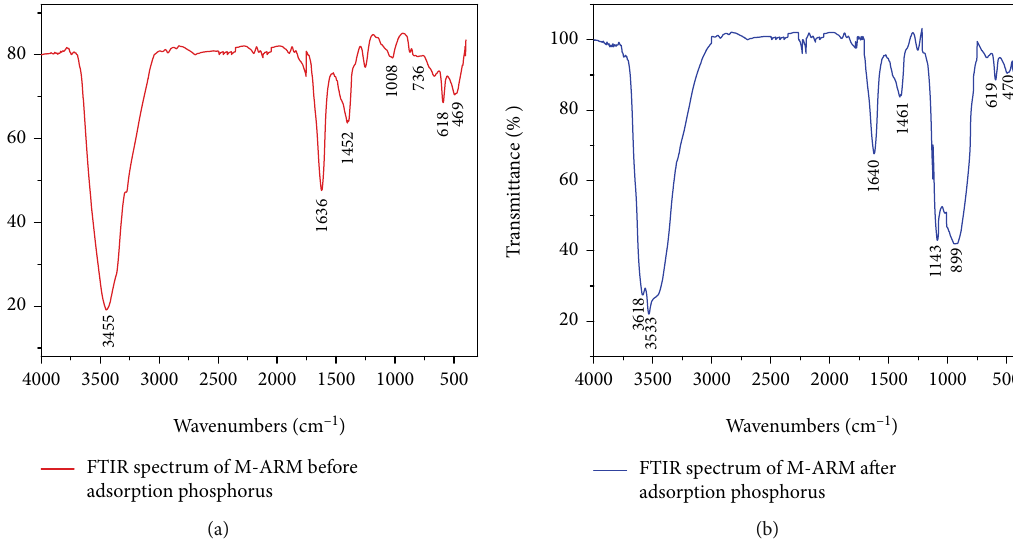
Figure 10: (a) FTIR spectrum of M-ARM material before phosphorus adsorption. (b) FTIR spectrum of M-ARM material after phosphorus